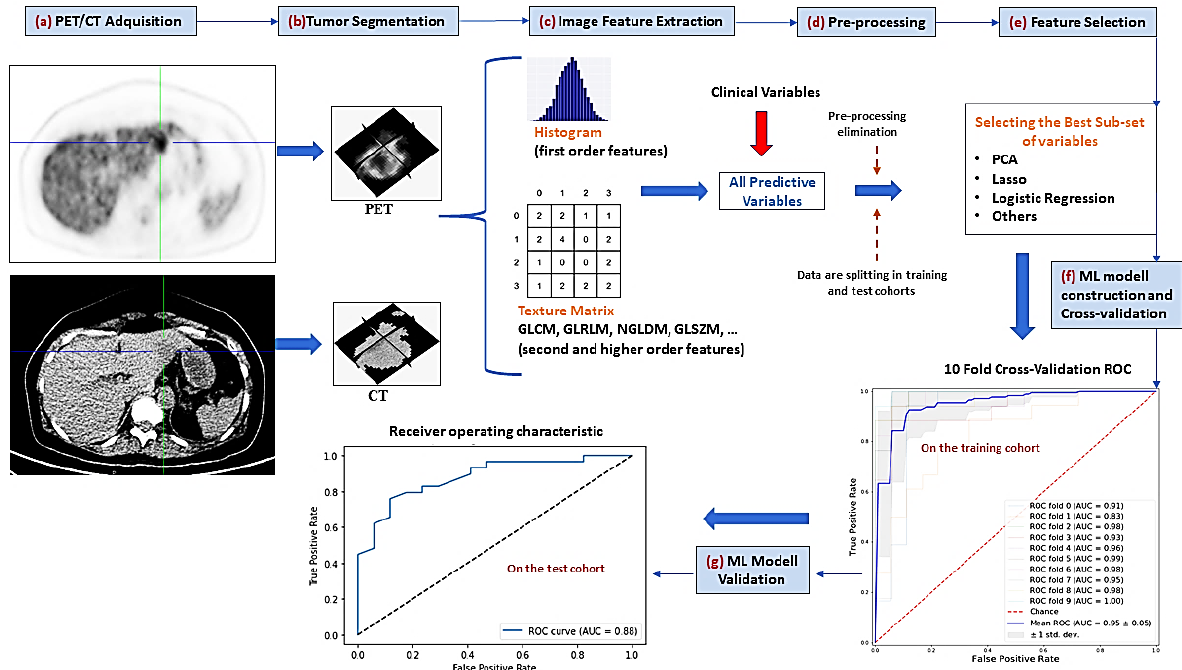
Figure 1. Radiomic pipeline process. ( a ) the first step consisted of PET/CT image acquisition ( b ) the tumor volume of interest is semi-automatically segmented ( c ) several first order and textural image features are extracted ( d ) a preprocessing step allowed to eliminate those highly correlated variables or with small variance ( e ) feature selection methods are applied to reduce the number of predictive variables ( f ) different machine-learning (ML) classifiers are used to construct the predictive models by using only the training cohort. Hyperparameter adjustment of these ML methods is performed by cross-validation ( g ) performance evaluation of predictive models by AUC-ROC analysis on the test cohort. PCA = principal component analysis, GLCM = gray-level co-occurrence matrix, GLRLM = gray-level run length matrix, NGLDM = neighboring gray-level dependence, GLSZM = gray-level size zone matrix, AUC = area under the curve, ROC = receiver-operating